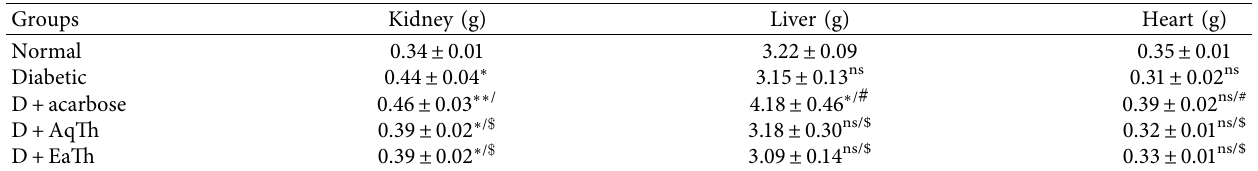
Table 4: Effect of 200 mg/kg AqTh, 50mg/kg EaTh, and 10mg/kg acarbose on kidney, liver, and heart weight in STZ-induced diabetic rats after 4-week